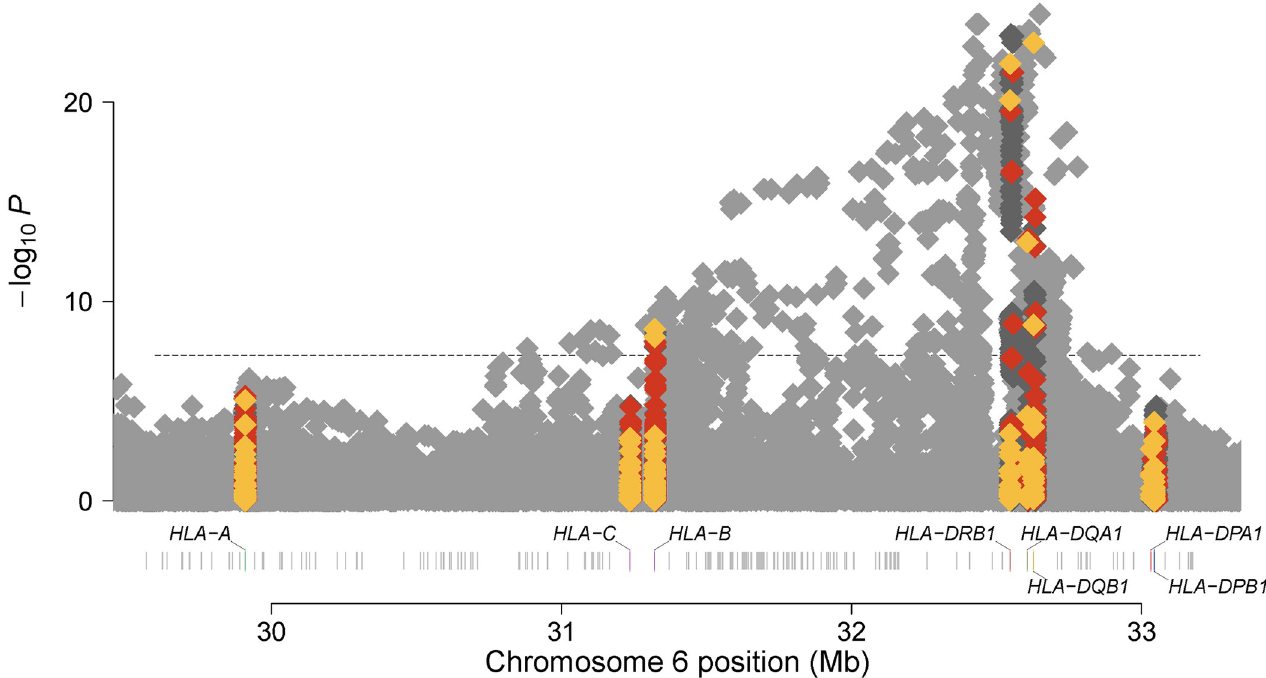
Fig 1. Manhattan plot for marginal additive association between variation within the MHC and MS risk in the Hispanic sample. Genomic position (HG19) is denoted on the x-axis and -log(10) P-value for the association of an additive effect of each SNP (grey), classical allele (yellow), and amino acid (orange) with MS risk on the